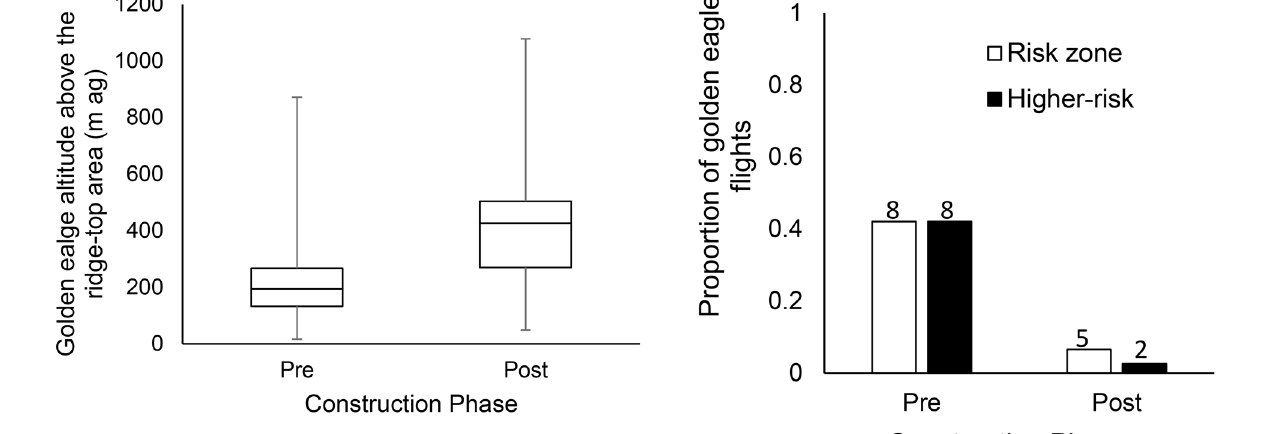
Figure 4. Golden eagle flight altitude (m above ground) above ridge top. Golden eagle flight altitudes above the ridge-top area during fall migration over one pre-construction ( n =60) and two post- construction ( n =148) seasons. Box represents median, first and third quartiles, and whiskers the maximum and minimum altitudes. Dashed line represents risk zone ( # 150 m above ground).